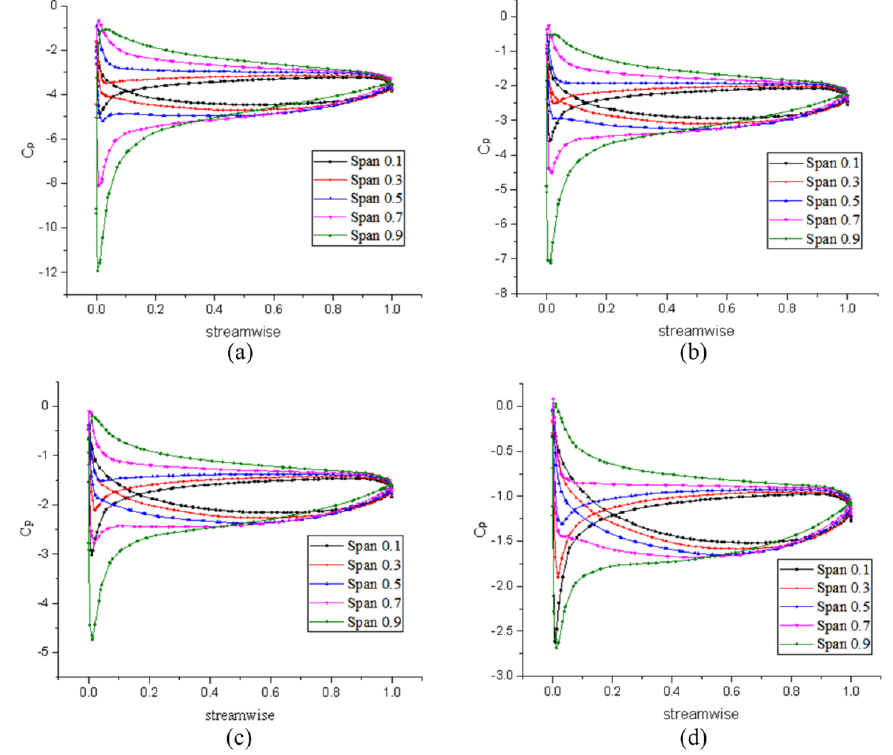
Figure 19. Tangential pressure distribution of stator matched with lifting-line method: ( a ) v = 7 m/s ( J = 0.78), ( b ) v = 8.5 m/s ( J = 0.95), ( c ) v = 10 m/s ( J = 1.12), and ( d ) v = 11.5 m/s ( J =